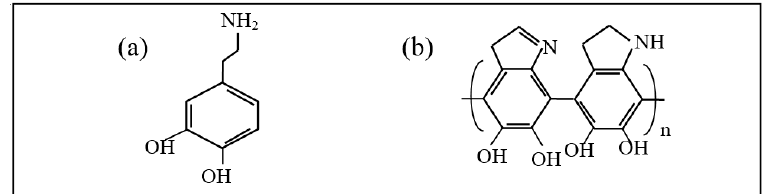
Figure 2. The structure of: ( a ) dopamine; ( b ) PDA .